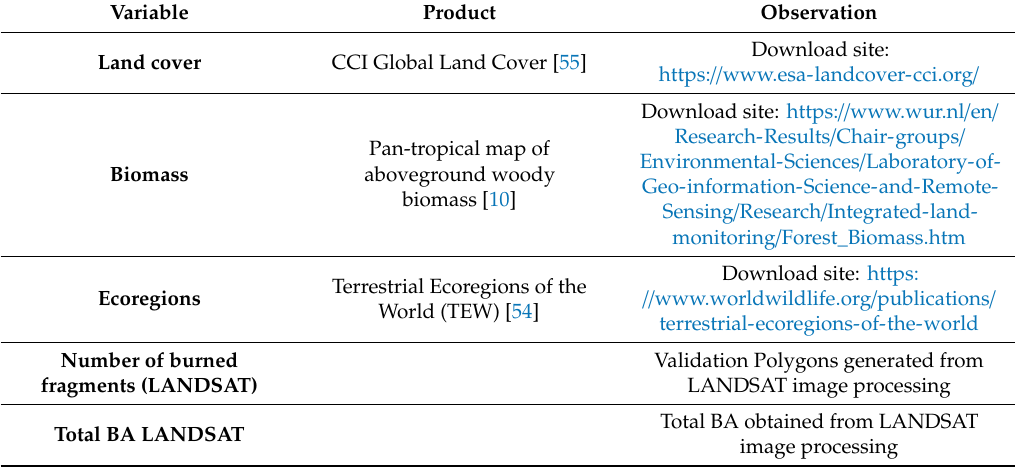
Table 2. Ancillary variables considered in the global